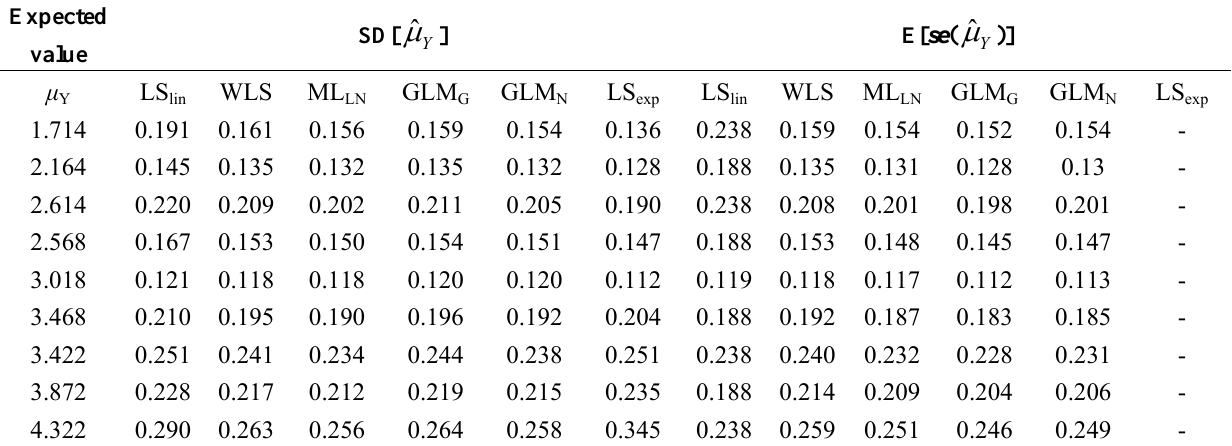
Table 3. True standard deviation and sample-specific standard error for the -values; . Results from simulation with n = 108 observations, r = 10,000